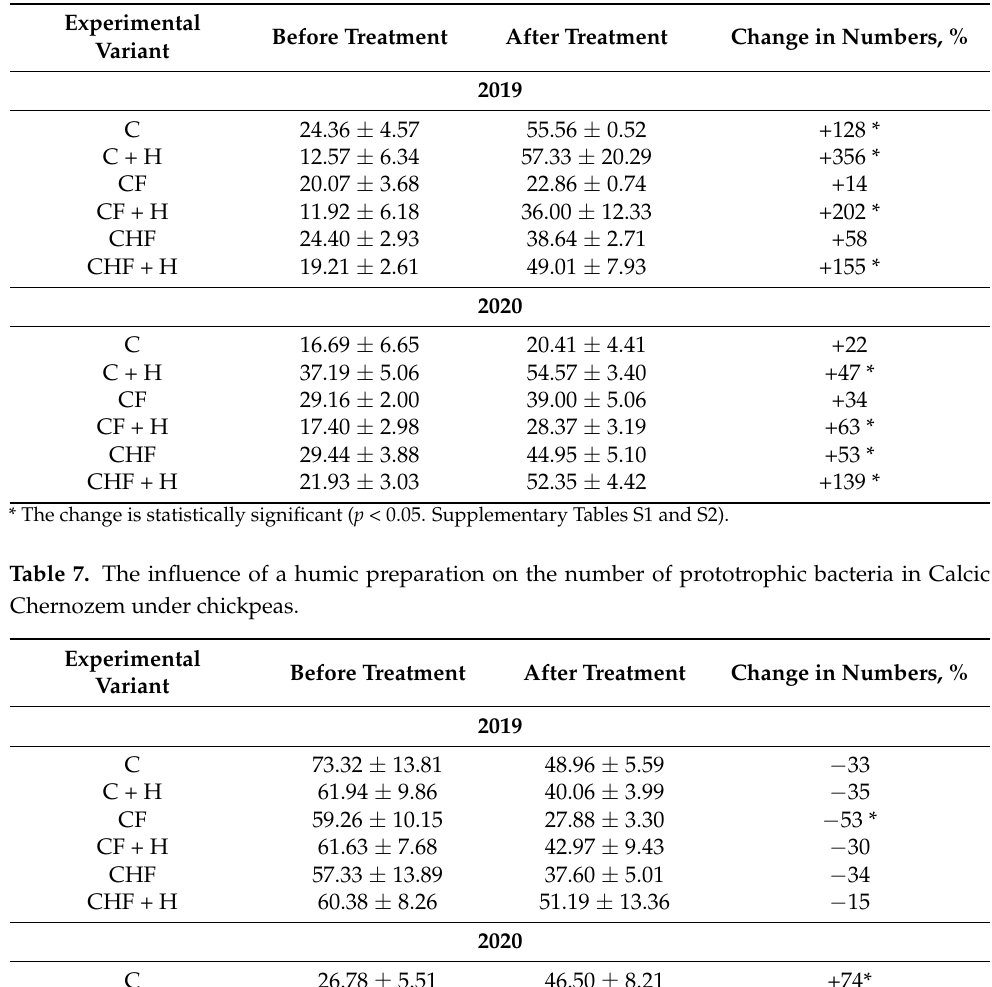
Table 6. The influence of a humic preparation on the number of copiotrophic bacteria in Calcic Chernozem under chickpeas.